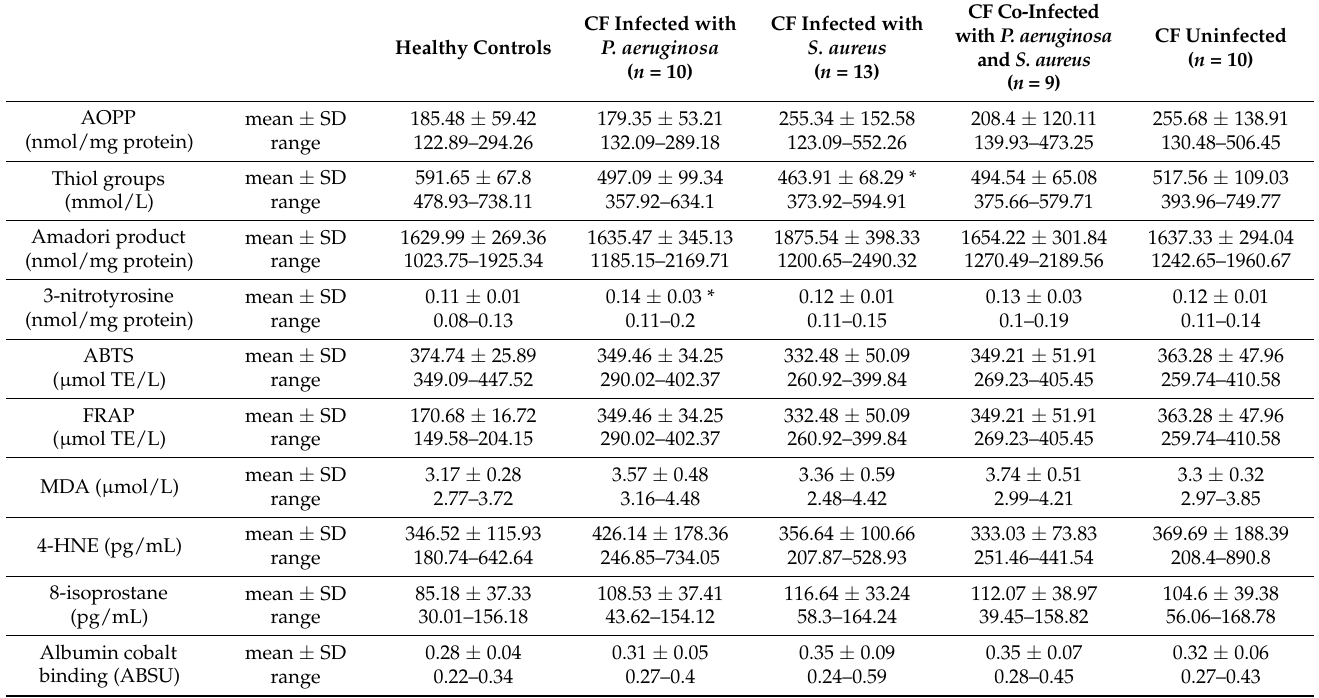
markers and albumin cobalt binding between the study groups (Table 4). Table 4. Markers of oxidative stress in participants with CF depending on bacterial infection a